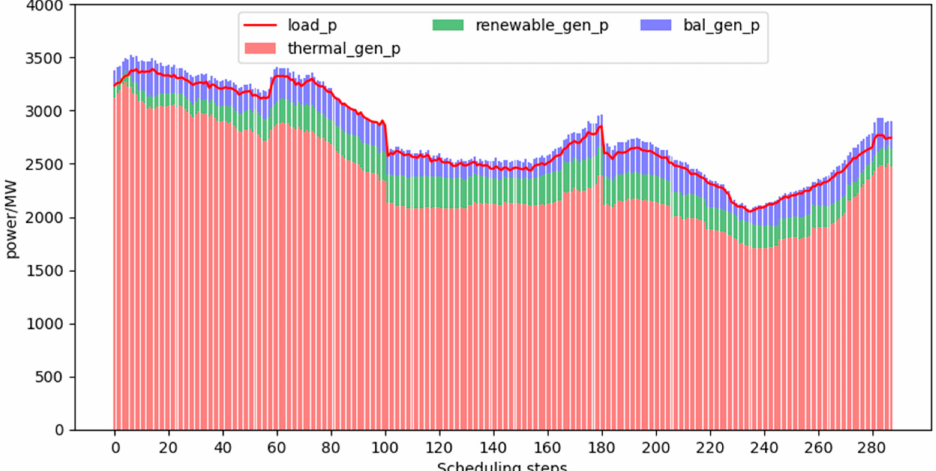
Figure 5. The scheduling period in which the total load is reduction.